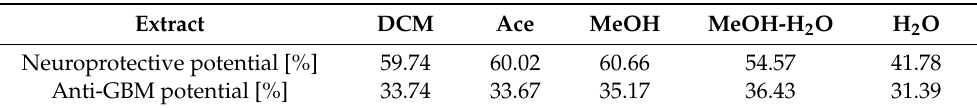
Table 9. The total biological potentials of P. glauca extracts as neuroprotective and Anti-GBM biological